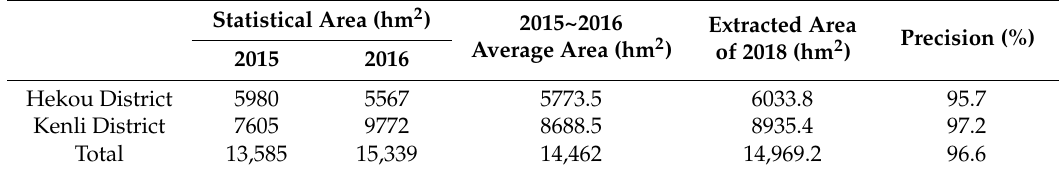
Table 10. Precision of winter wheat area extraction.